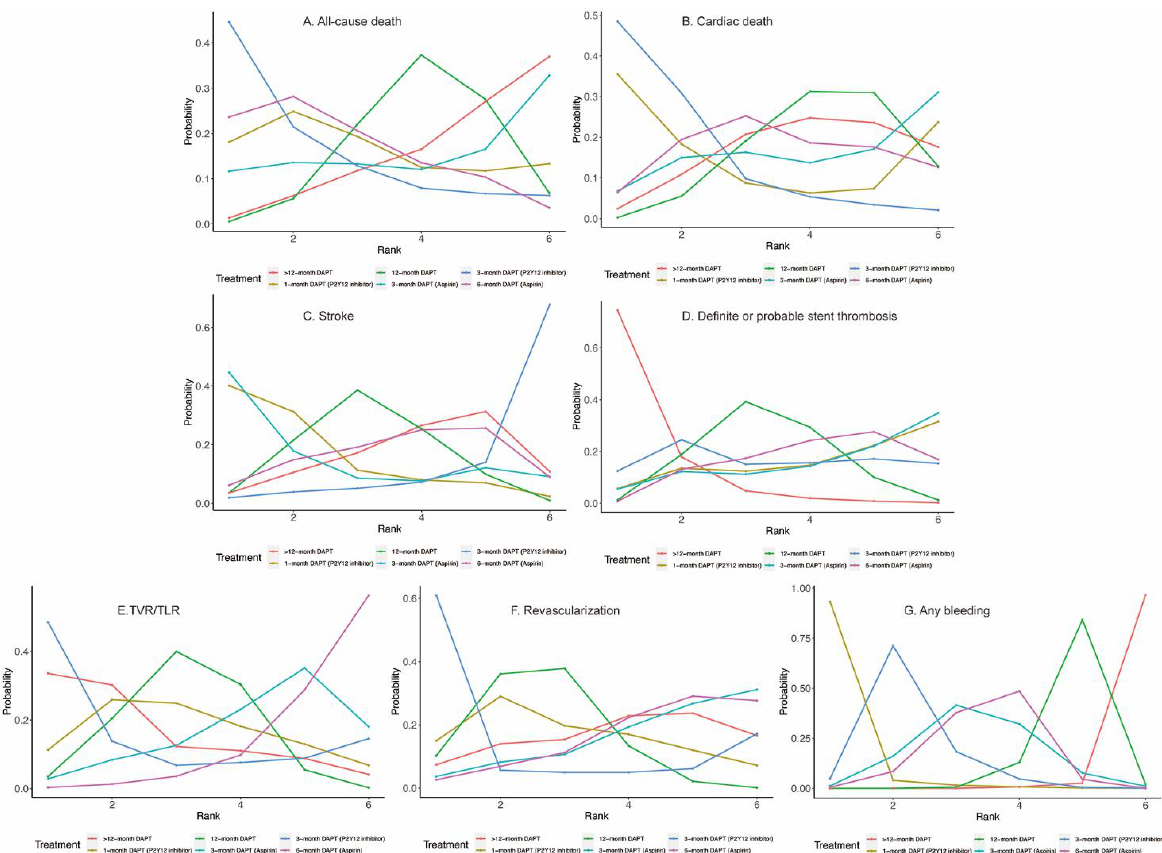
Figure 5. Rankograms for Secondary